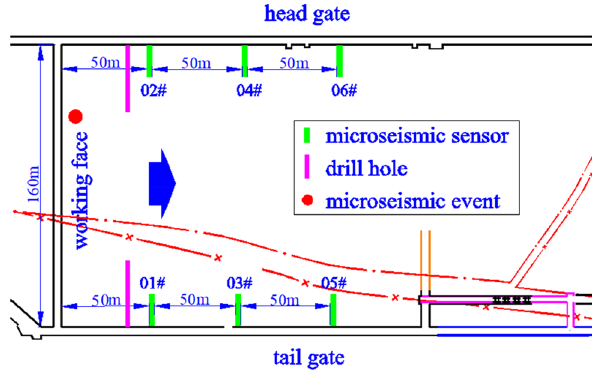
Figure 2. Site layout of microseismic